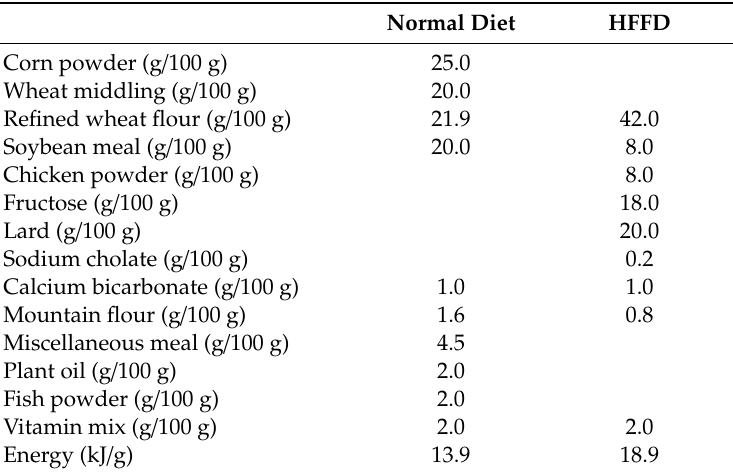
Table 1. Composition of